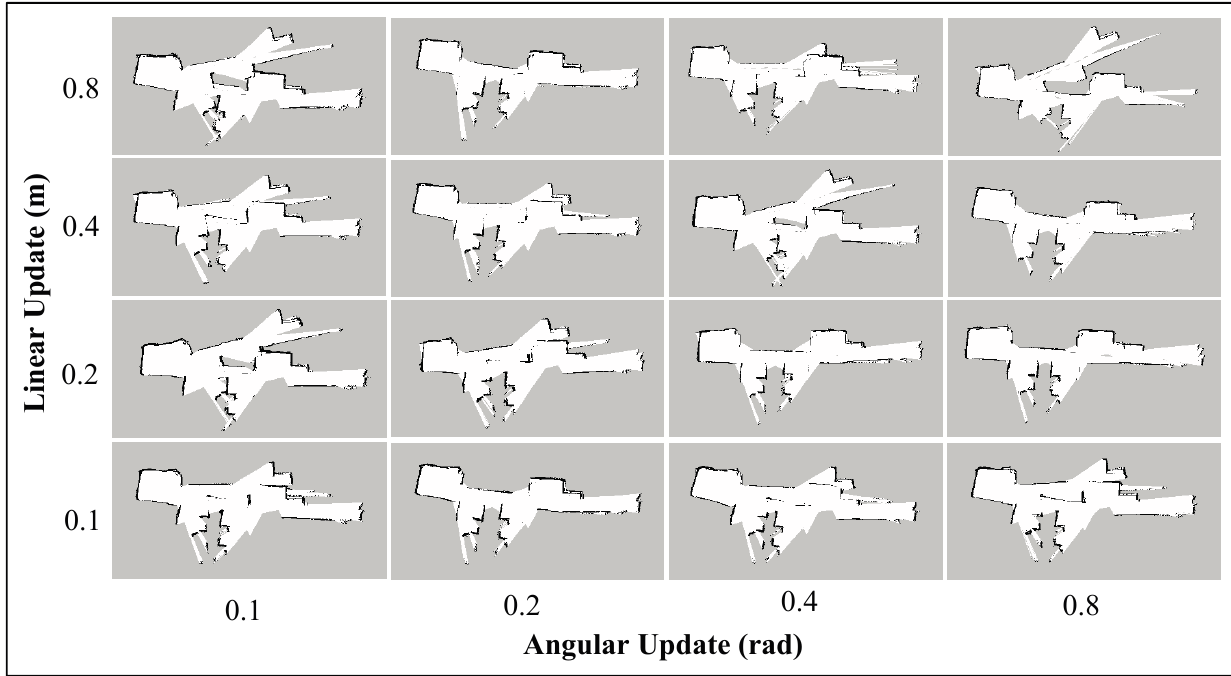
Figure 12. Corridor maps obtained using Gmapping technique with different combinations of Linear and Angular Update values.